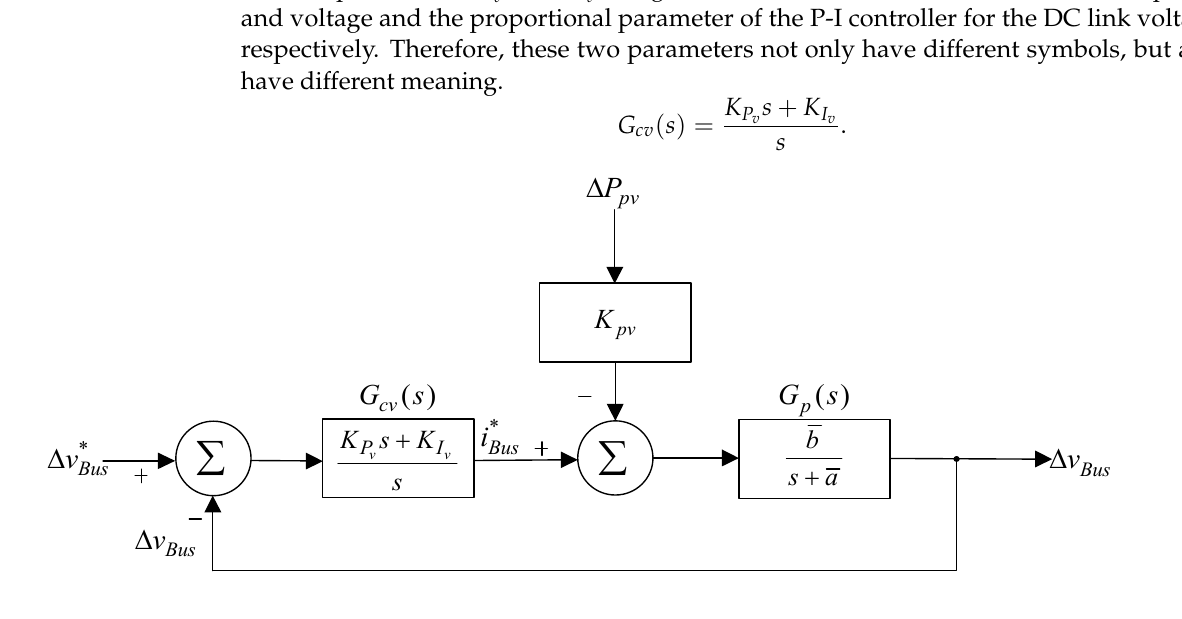
Figure 11. Block diagram of the voltage control loop.